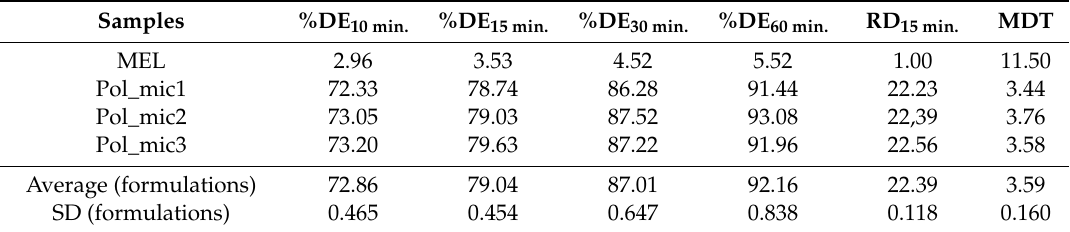
Table 9. Statistical analysis of the in vitro dissolution test.